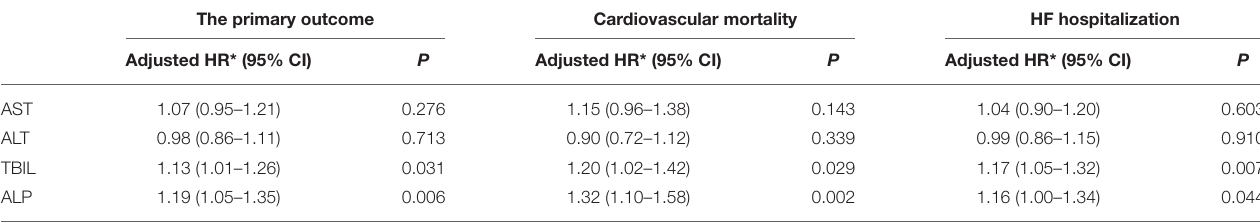
TABLE 6 | Associations of liver function tests and clinical outcomes in enrolled patients with BNP/NT-proBNP available ( n = 992). The primary outcome Cardiovascular